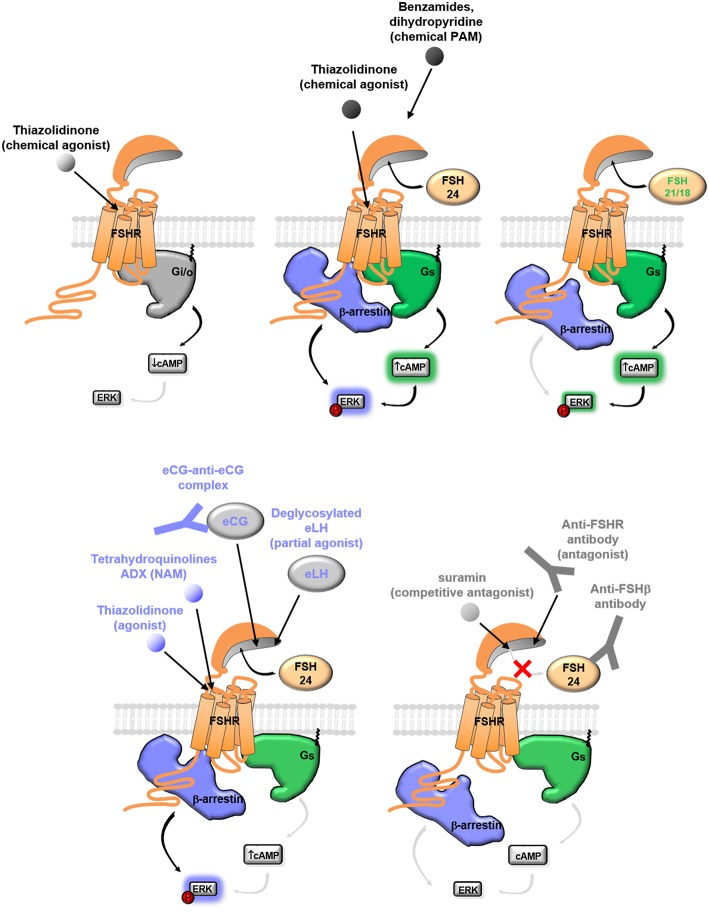
Ligand bias at the FSHR. Balanced agonists or PAM at the FSHR induce both G protein and β-arrestin recruitment. FSH binding to the FSHR can be prevented using small competitive ligands, antibodies directed against the binding pocket of the FSHR or directly against FSH. Biased signaling toward Gαi, Gαs, or β-arrestin recruitment can result from glycosylation forms of FSH (fully glycosylated FSH24 vs partially glycosylated FSH21-18), antibody or small chemical compounds.